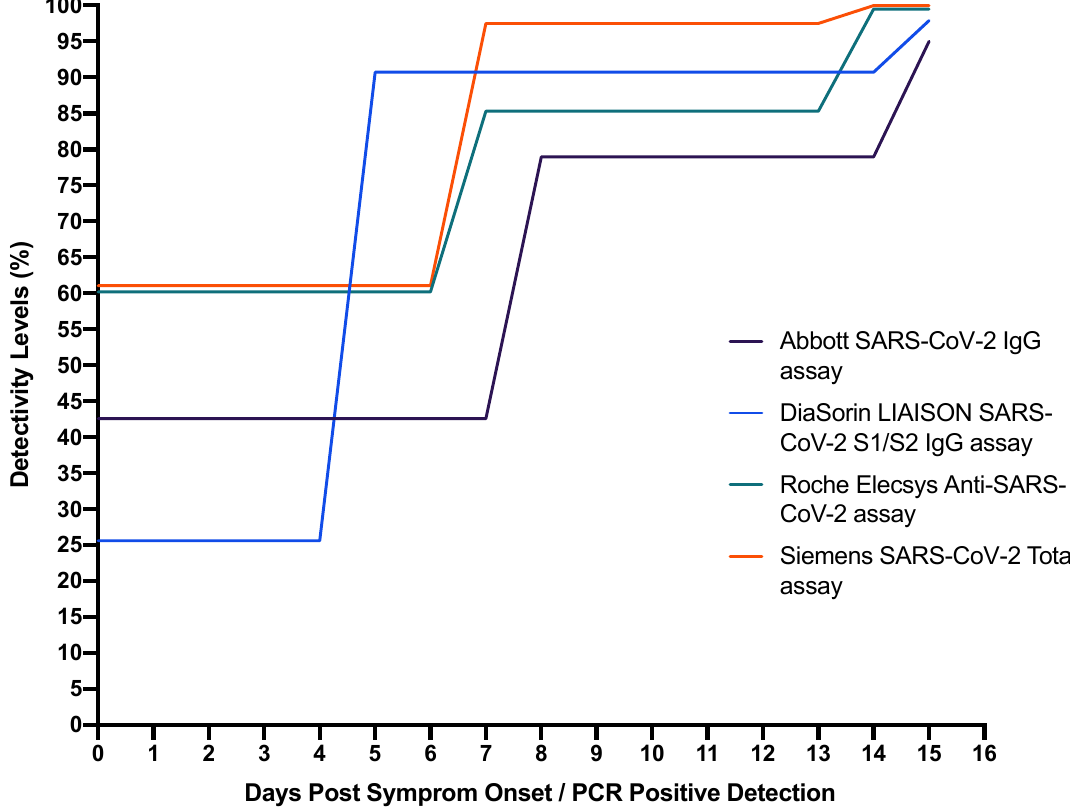
Figure 1. The time sensitive changes of antibody detectivity levels within COVID-19-positive patients over time when tested using available and marketed commercial kits—Abbott, DiaSorin, Roche and Siemens.